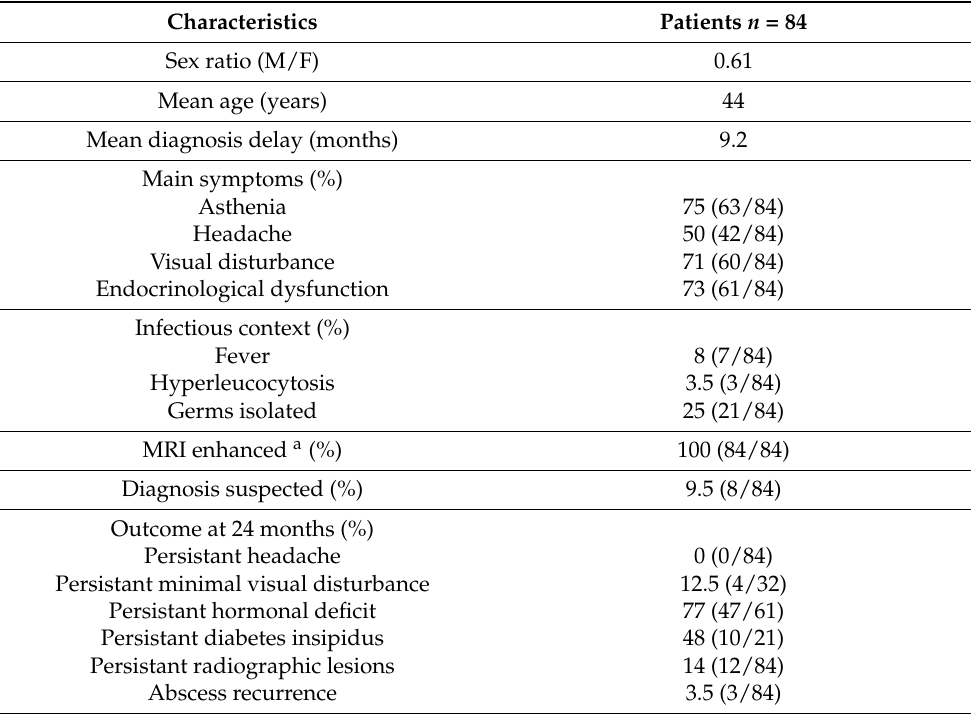
Table 1. PA patient series: demographic and clinical